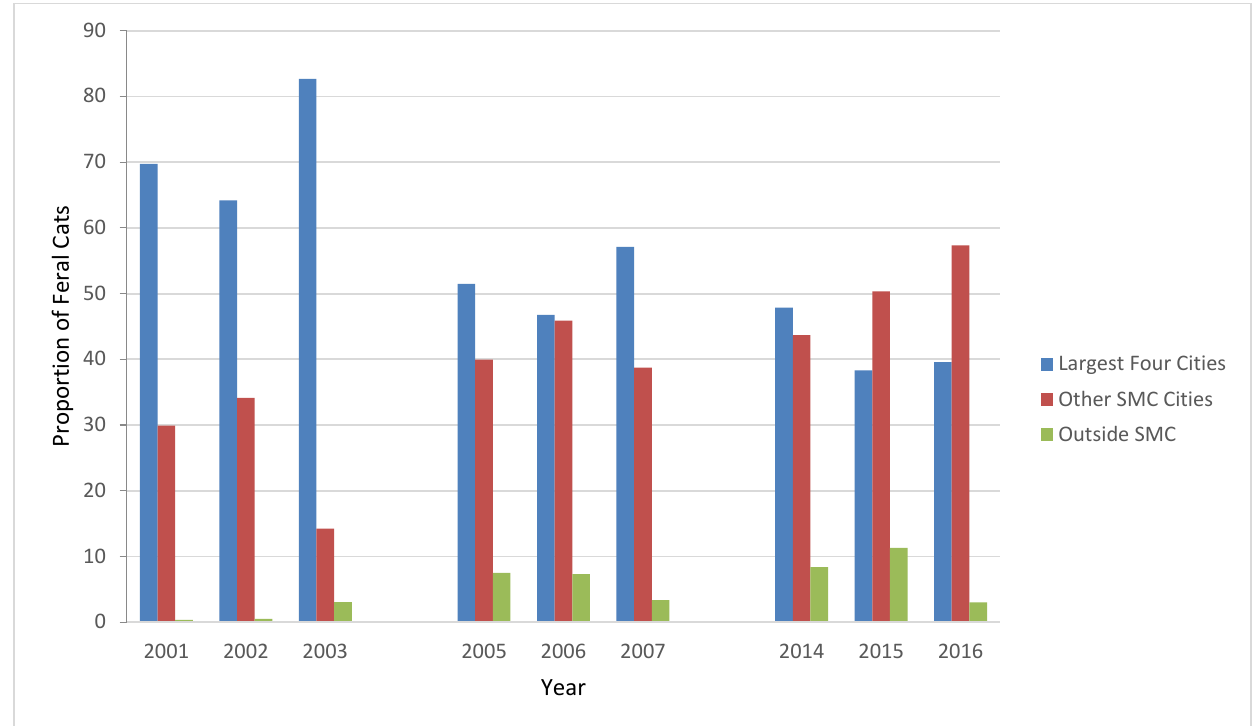
Figure 5. Proportions of feral cats, by source location, presented to the PHS Spay/Neuter Clinic, 2001–2003, 2005–2007, and 2014–2016. SMC—San Mateo County. Table 5. Feline leukemia virus positive prevalence, stratified by source location within San Mateo County, among feral cats presented to the PHS Spay/Neuter Clinic in the years 2001–2003, 2005–2007, and 2014–2016